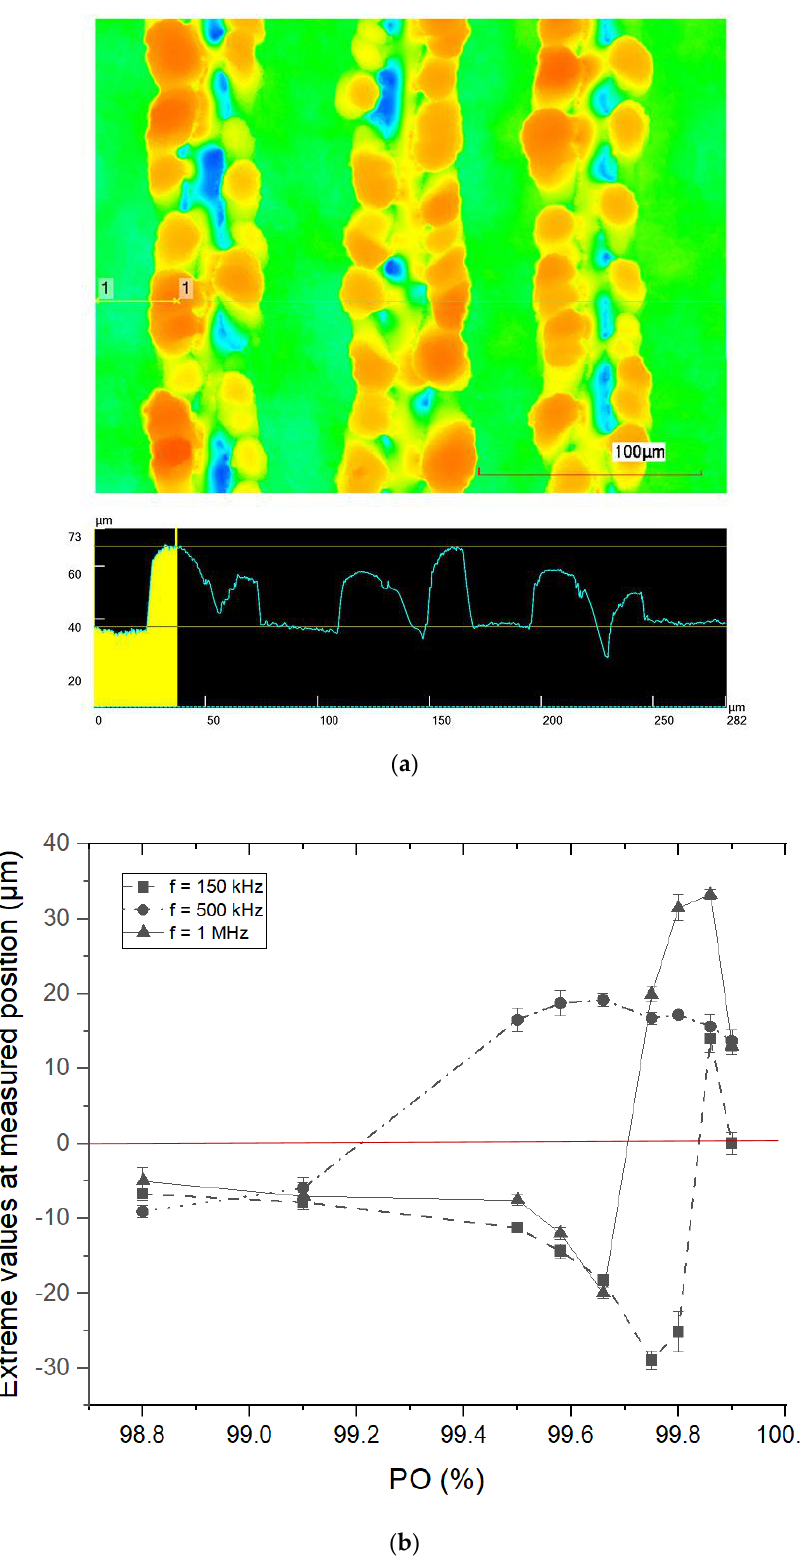
Figure 2. CLSM results of surface topography evolution during laser texturing: ( a ) Representative CLSM image of the surface profile at a measured position (black line); ( b ) mean extreme values at a measured position at f = 150 kHz, f = 500 kHz, and f = 1 MHz (measuring position and mean deviation from N = 5